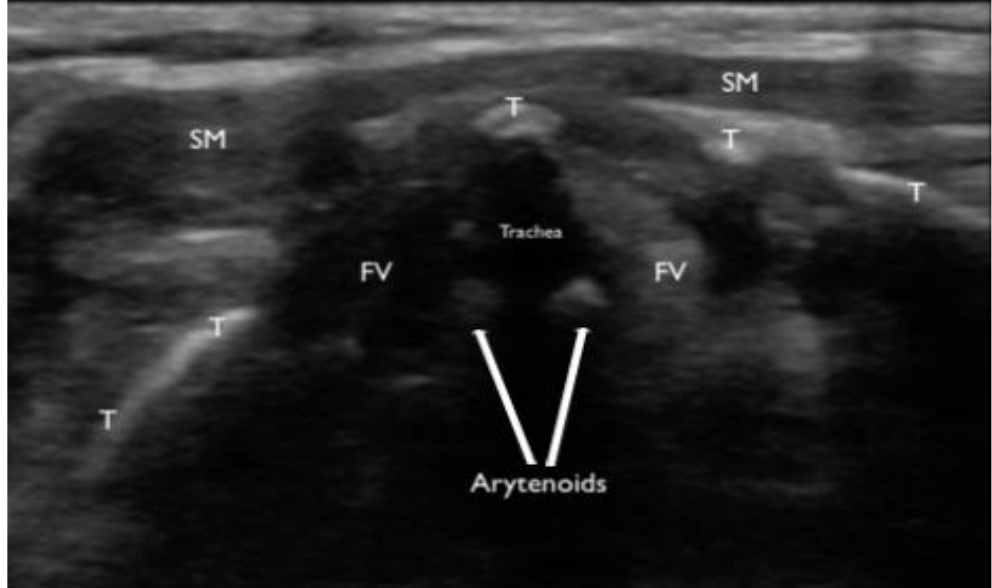
Figure 2. A transverse still image of the upper airway taken with a high frequency, linear transducer at the level of the arytenoid cartilage. Sternocleidomastoid muscle (SM) and thyroid cartilage (T) are re-demonstrated. The false vocal cords (FV) are visualized with noted asymmetry, edema on the patient’s left side (right side of the image).